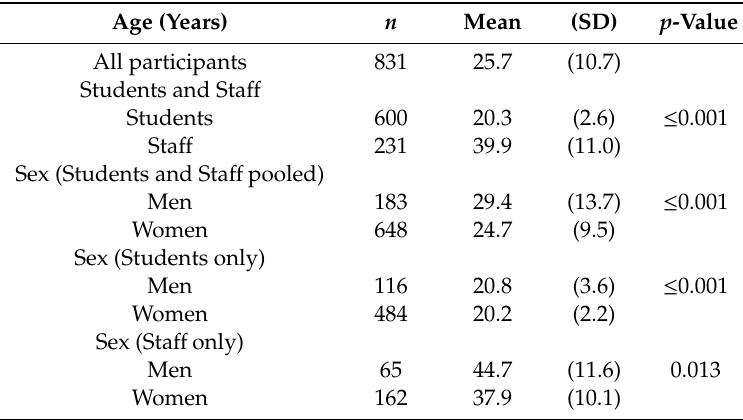
Table 1. Mean ages (standard deviations) of the